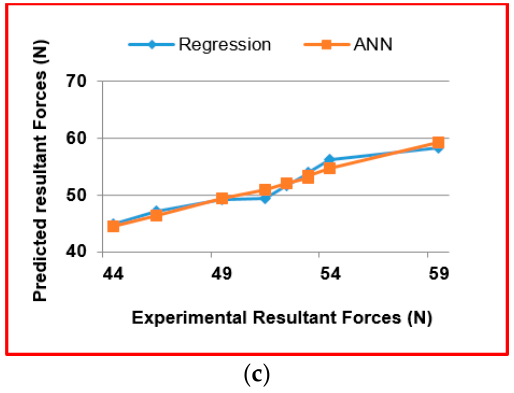
Figure 11. Comparison between regression model and ANN model with the experimental resultant forces. ( a ) at Tool T1; ( b ) at Tool T2; ( c ) at Tool T3.